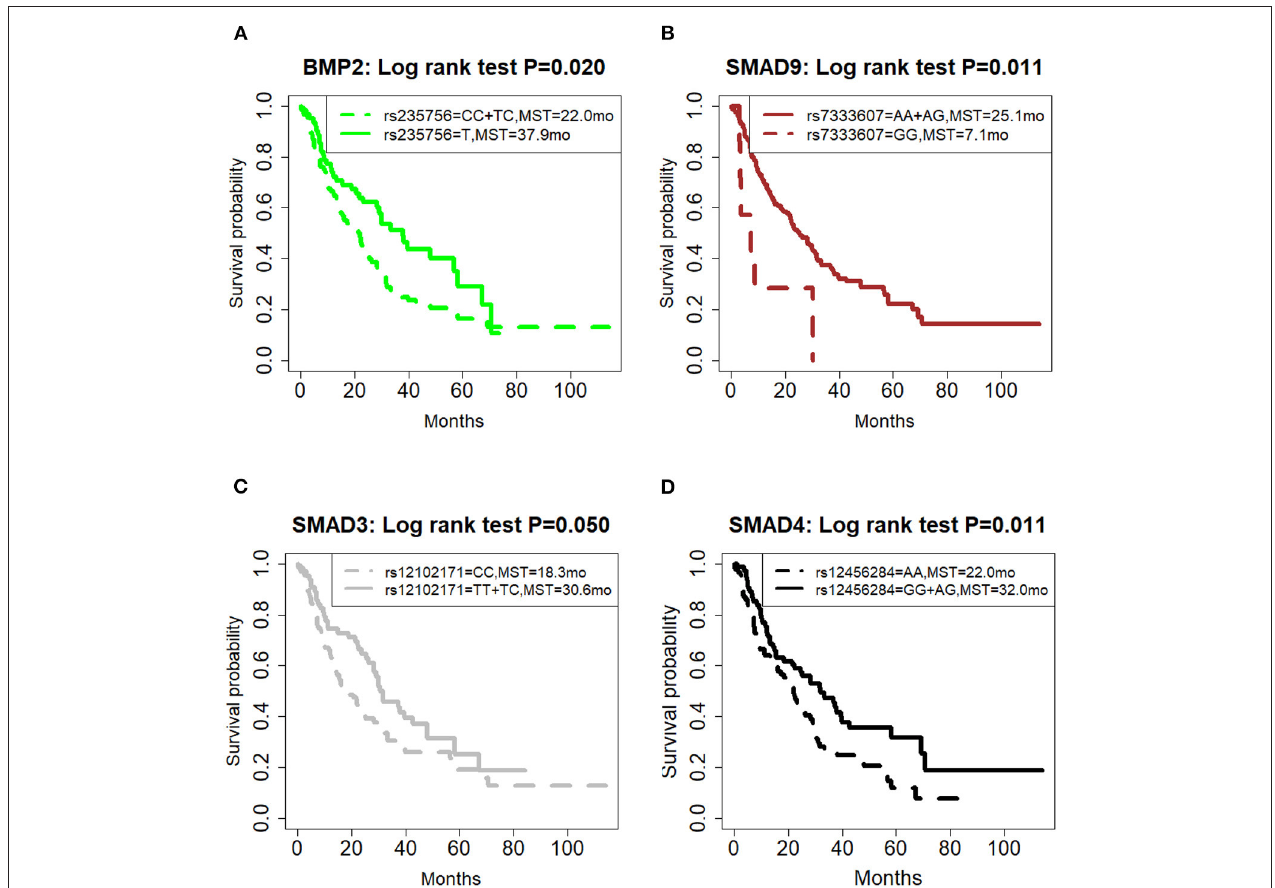
FIGURE 1 | Effect of genetic variation on Kaplan-Meier overall survival curve. (A) BMP2:rs235756; (B) SMAD9:rs7333607; (C) SMAD3:rs12102171; (D) SMAD4: rs12456284; MST in months. MST, median survival